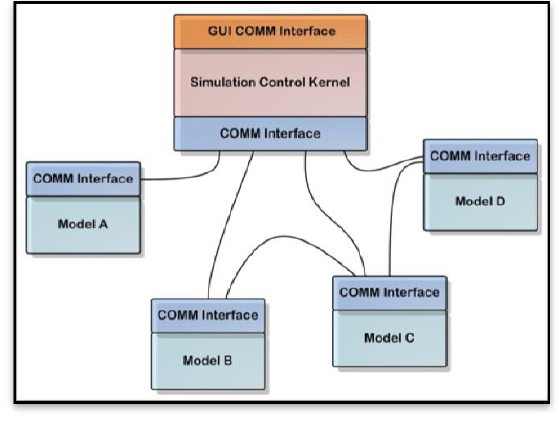
Fig. 12. A generic scheme for a distributed simulation